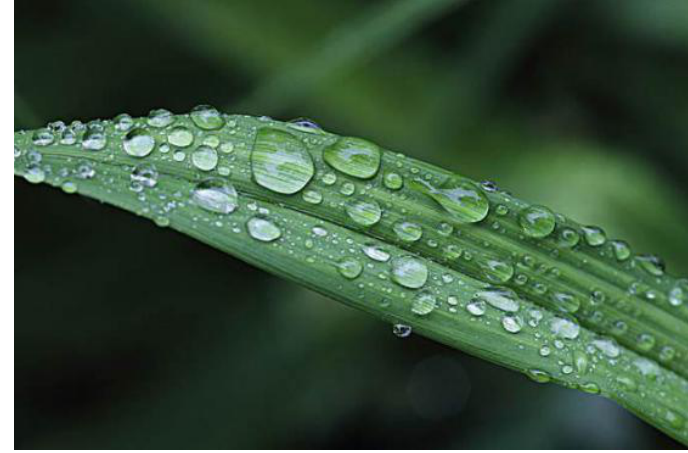
Figure 1. Non-spherical droplets on a grass leaf.